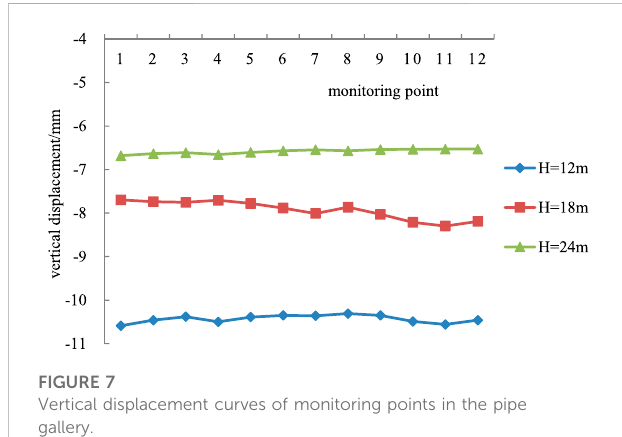
FIGURE 7 Vertical displacement curves of monitoring points in the pipe